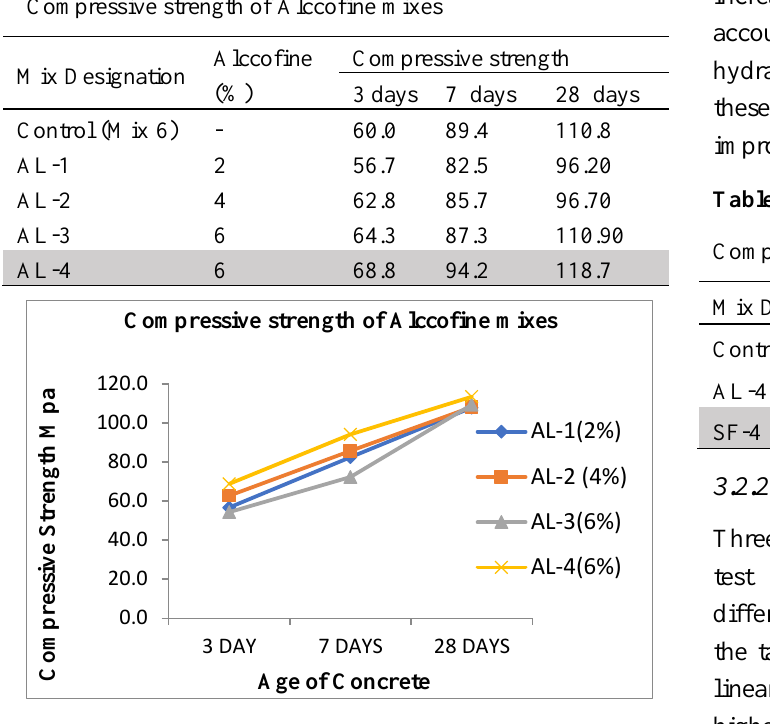
Fig. 13. Compressive strength of Alccofine mixes .